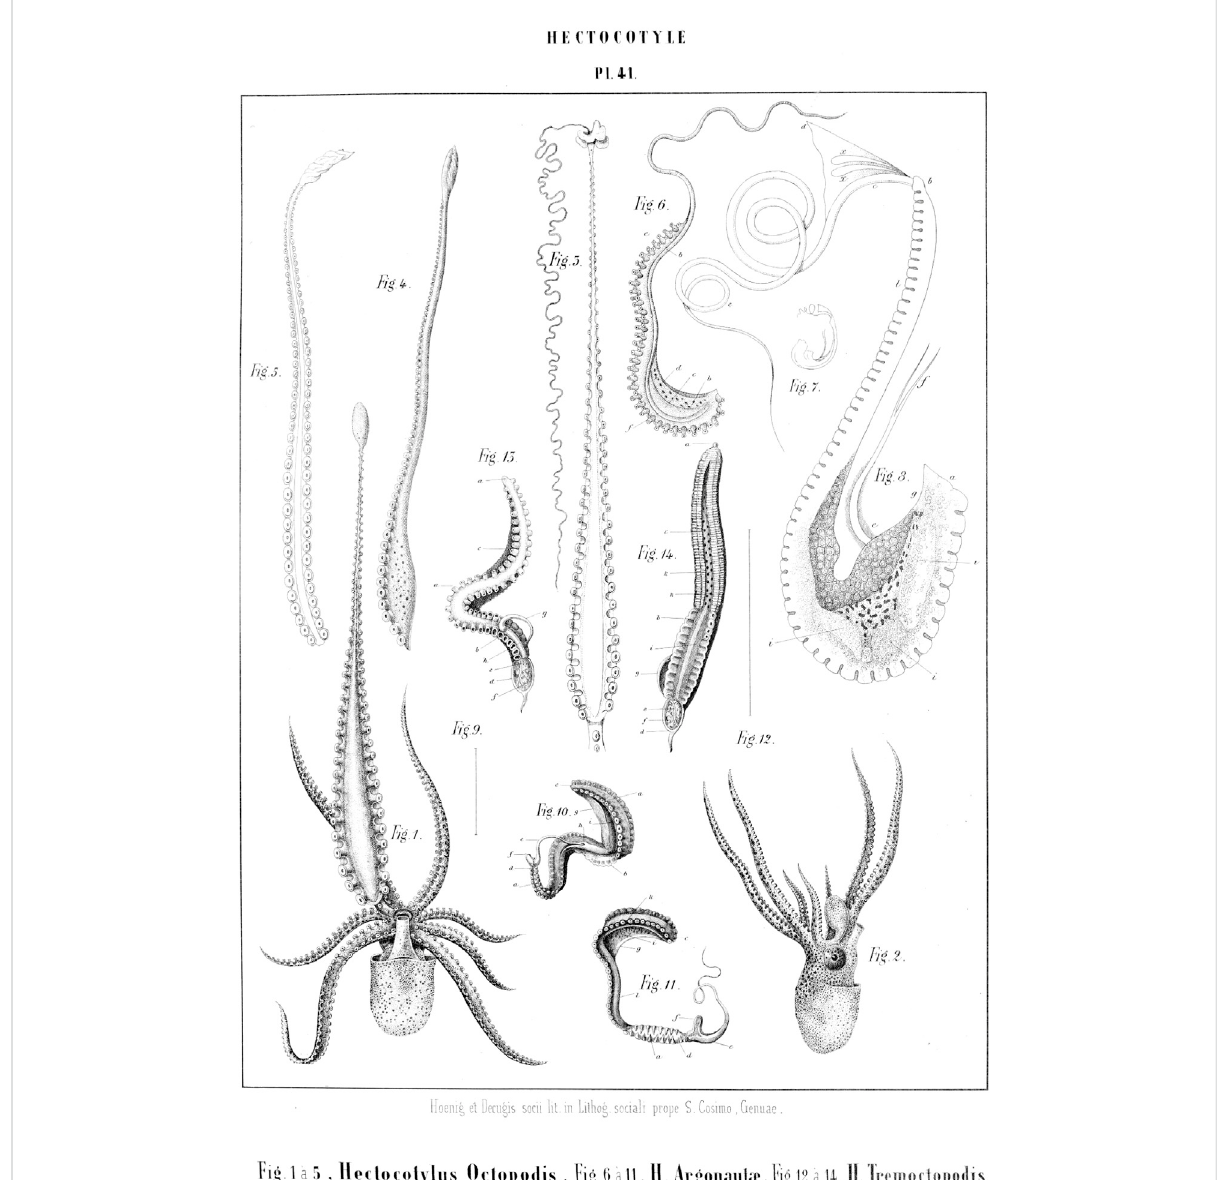
FIGURE 1 Hectocotyli of cephalopods. 1-5. Octopus vulgaris ; 6-11. Argonauta argo ; 12-14. Tremoctopus violaceus (Vérany, 1851, table 41. Out of copyright).